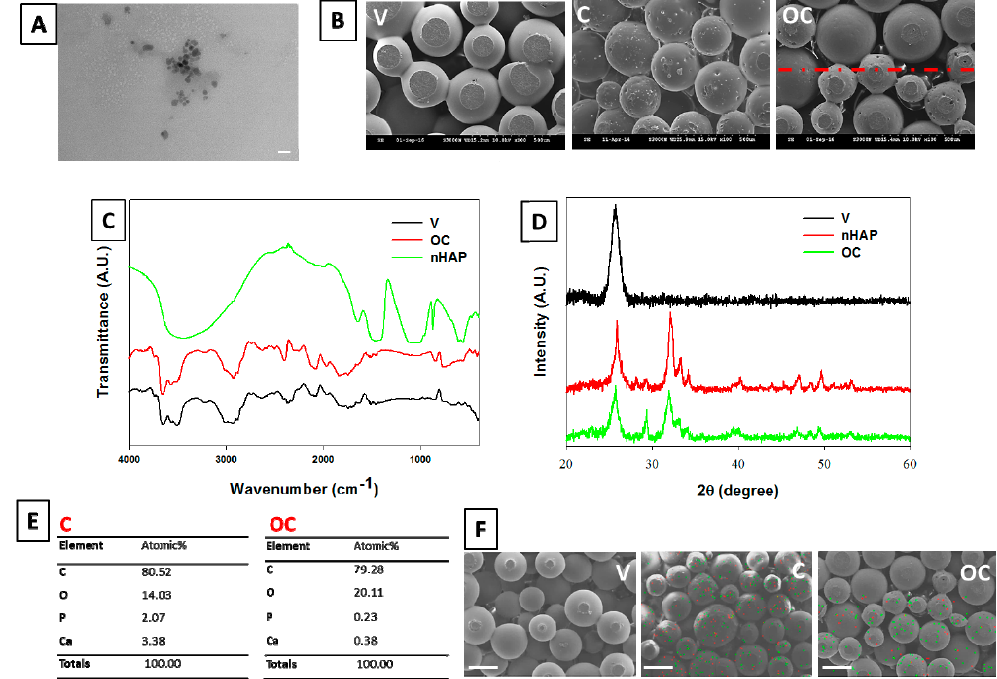
Figure 2. Physico-chemical properties of scaffolds. ( A ) TEM image of nHAP (bar = 20 nm); ( B ) SEM images of V, C, and OC scaffolds; ( C , D ) FTIR and XRD of nHAP and V and OC scaffolds; ( E ) EDX elemental atomic compositions of C and OC scaffolds; ( F ) elemental mapping of V, C, and OC scaffolds with Ca and P as green and red dots, respectively (bar = 300 µm). The red line in ( B ) indicates the interface region in the OC scaffold.